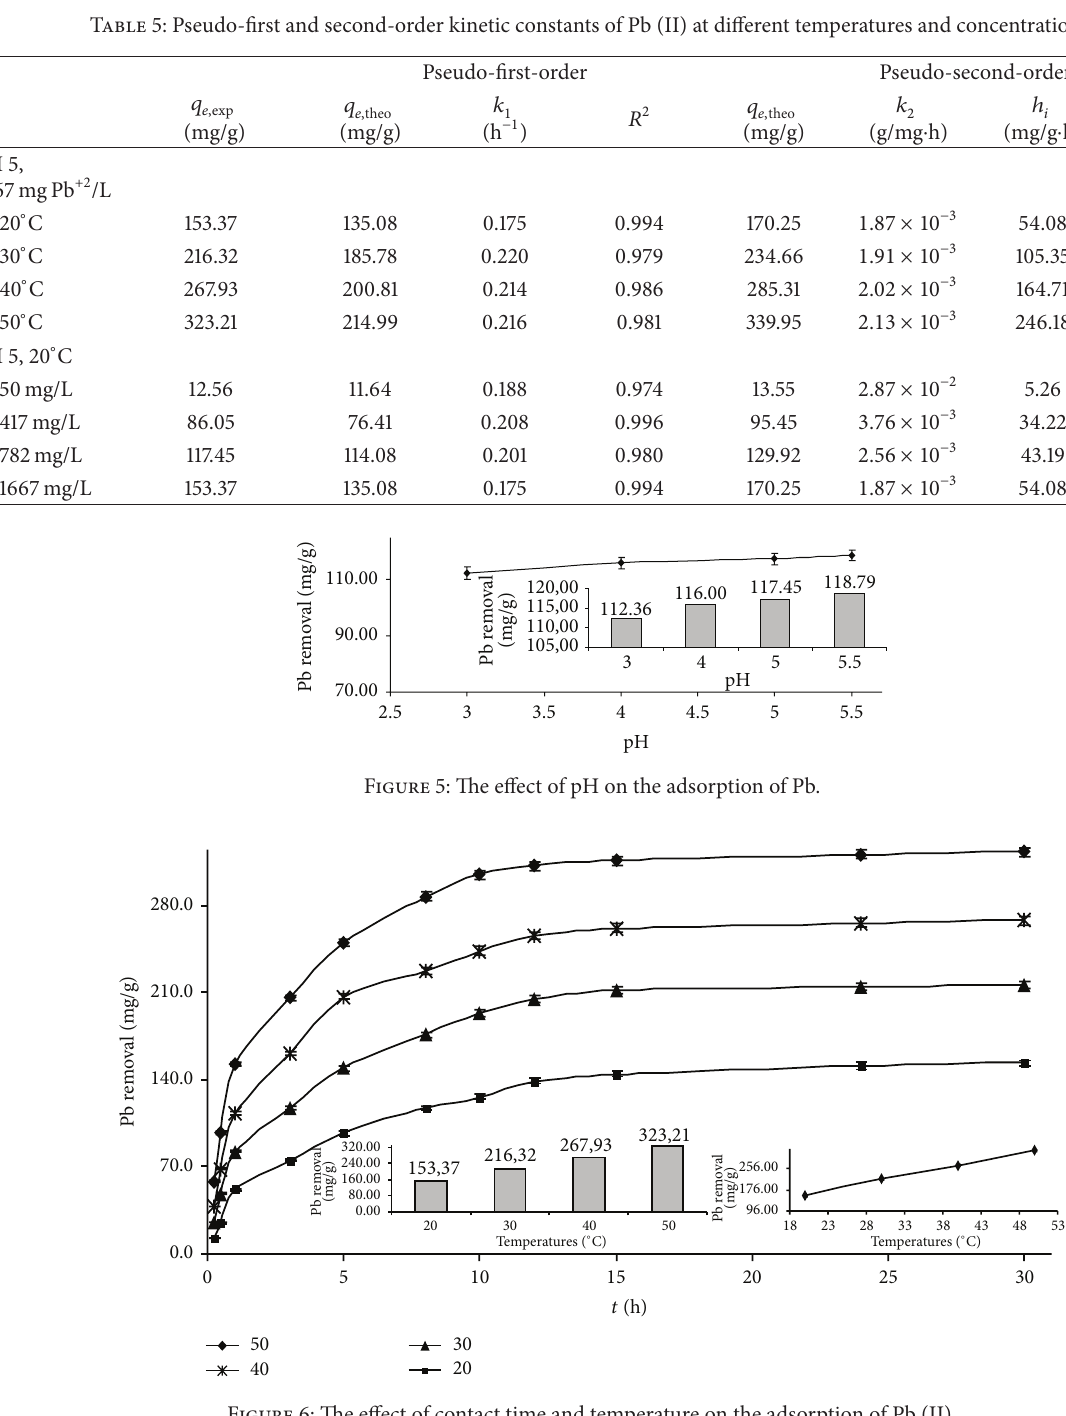
Figure 6: The effect of contact time and temperature on the adsorption of Pb